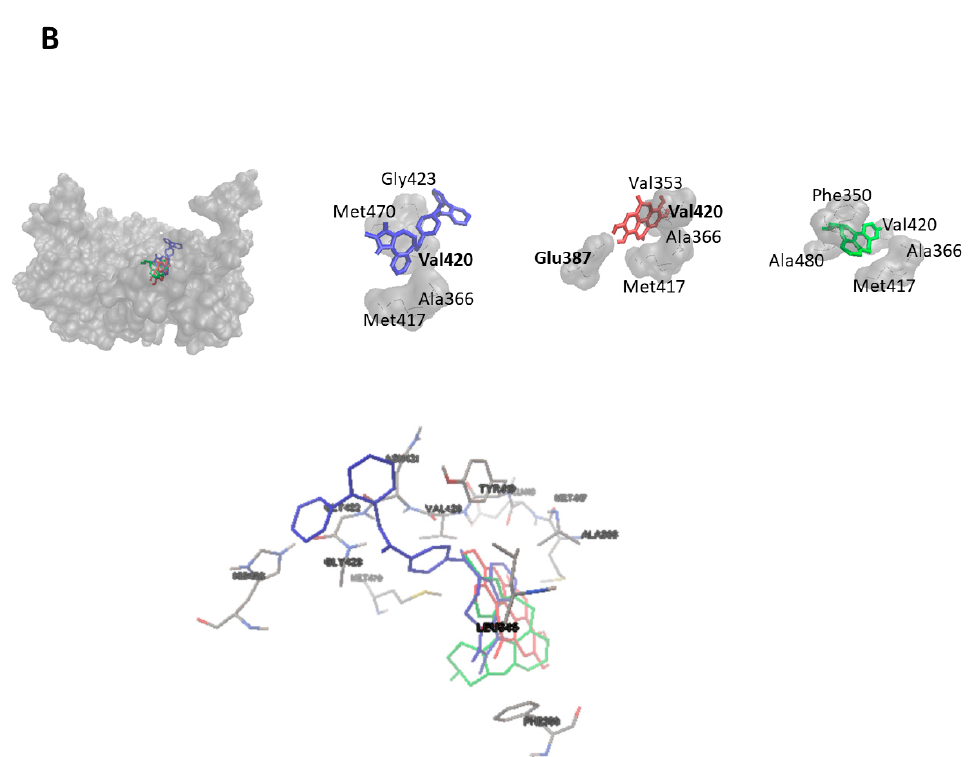
Figure 5. Molecular docking poses of conivaptan (blue) and bexarotene (green) on ( A ) HMOX1 and that of conivaptan (blue) and desloratadine (green) on ( B ) PRKCA. The known HMOX1 inhibitor 1-(adamantan-1-yl)-2-(1H-imidazol-1-yl)ethenone and the known PRKCA inhibitor ellagic acid are displayed in red. Amino acid residues forming hydrogen bonds are displayed in bold.